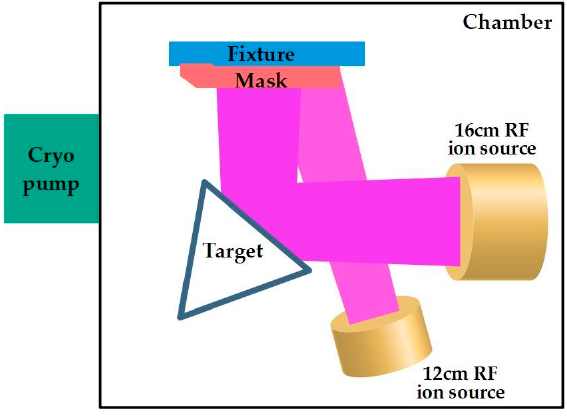
Figure 2. Dual ion beam sputtering system.